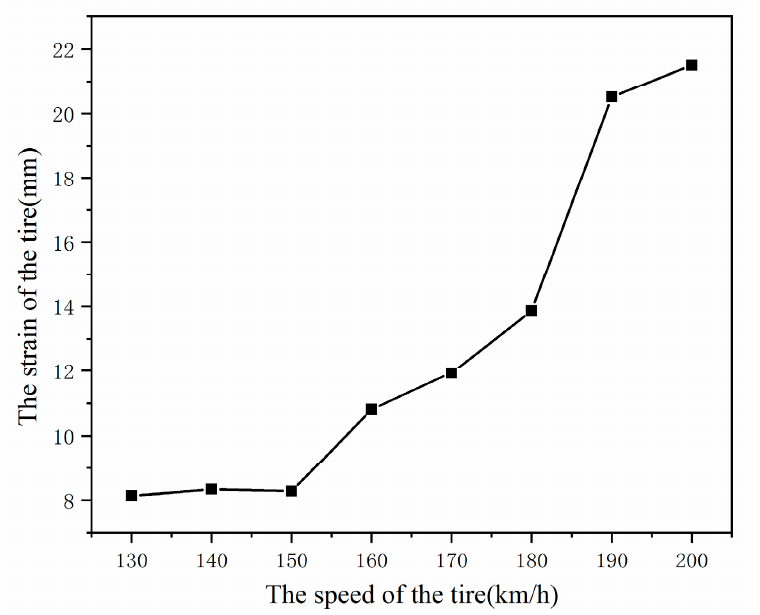
Table 4. Parameter conditions adopted in the simulation.